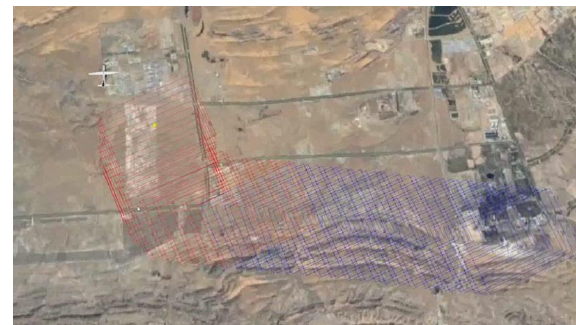
Figure 12. Real-time footprints of high-resolution video Figure 13 shows the orthomosaic dynamically generated using the images and POS data collected during the flight in 2016. The ground sample distance of the orthomosaic is set to 1 meter. The time spent for ortho-rectification and mosaicking of each image is at the level of several seconds. An overview of the imaged area can be immediately obtained from the orthomosaic. It should be mentioned that the boundaries of neighboring images are not well merged because no bundle block adjustment has been done.